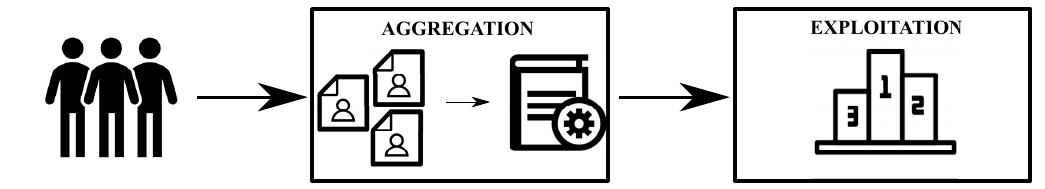
Figure 1. GDM resolution scheme.